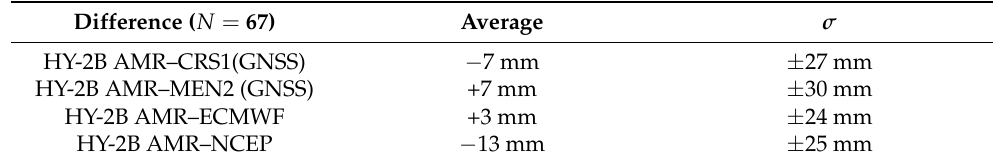
Table 5. Differences of wet tropospheric corrections as derived from the radiometer on-board HY-2B, CRS1 and MEN2 GNSS stations, as well as the NCEP and ECMWF global models. Difference ( N = 67) Average σ HY-2B AMR–CRS1(GNSS)